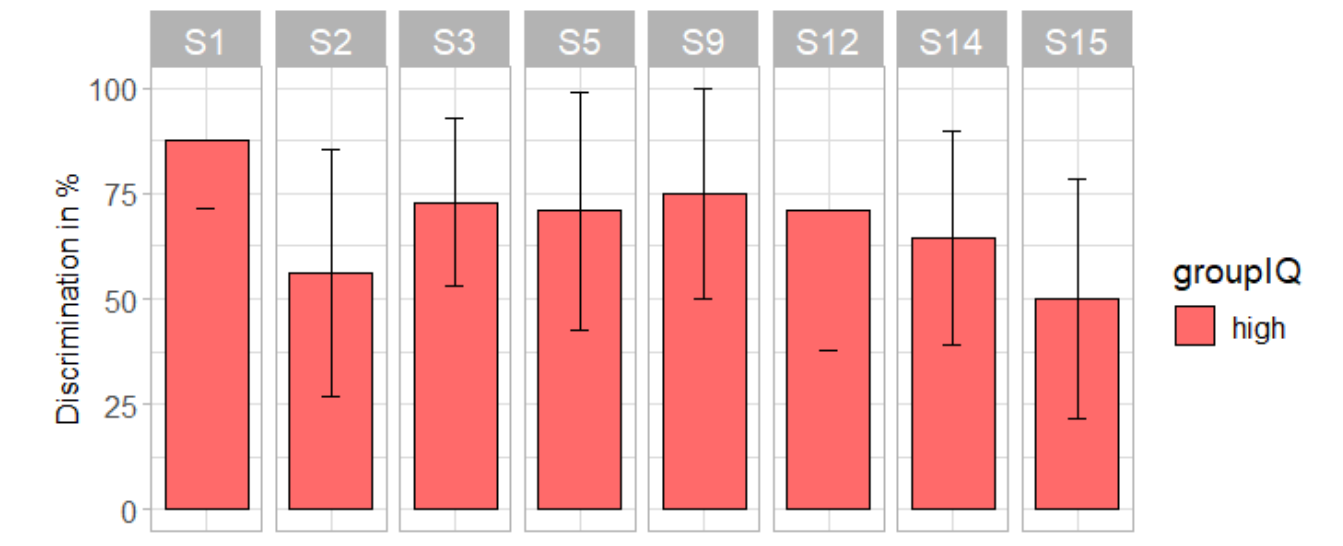
Figure 3. Discrimination of contrasts by each subject in the high IQ group.